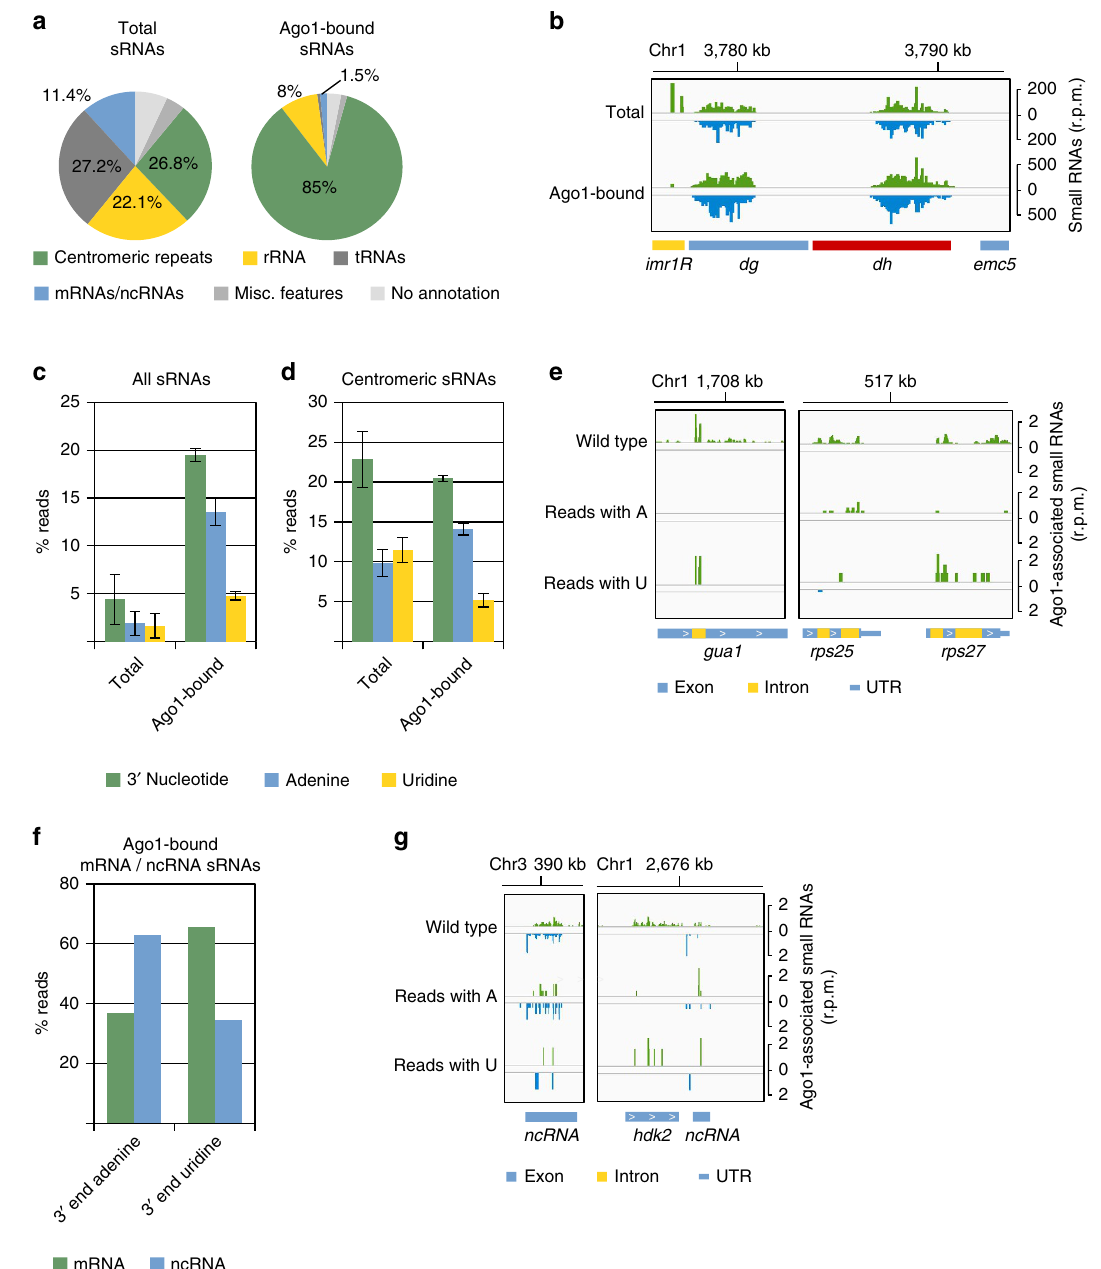
Figure 1 | Argonaute-bound sRNAs have non-templated nucleotides at the 3 0 end. ( a ) Argonaute-bound and total sRNAs were analysed by high- throughput sequencing from wild-type cells and classified as indicated below the pie charts. Pie charts illustrate percentages for the individual sRNA classes relative to the total number of reads for each strain. ( b ) Argonaute-bound and total sRNA reads from wild-type cells were plotted over centromeric region. The location of genes is indicated below the sRNA peaks. Reads from þ and (cid:2) strands are depicted in green and blue, respectively. Scale bars on the right denote sRNA read numbers normalized per one million reads. ( c ) Quantification of sRNAs that have non-templated nucleotides at the 3 0 end in Argonaute-bound and total sRNA sample. Error bars indicate s.e.m. of two independent sRNA-sequencing experiments. ( d ) Quantification of centromeric sRNAs that have non-templated nucleotides at the 3 0 end in Argonaute-bound and total sRNA sample. Error bars indicate s.e.m. of two independent sRNA-sequencing experiments. ( e ) Argonaute-bound sRNA reads from wild-type cells were plotted over euchromatic region. Reads having non-templated adenine(s) or uridine(s) at the 3 0 end are shown in separated tracks. The location of genes is indicated below the sRNA peaks. Reads from þ and (cid:2) strands are depicted in green and blue, respectively. Scale bars on the right denote sRNA reads numbers normalized per one million reads. ( f ) Quantification of Argonaute-bound sRNAs that have non-templated adenine(s) or uridine(s) at the 3 0 end. Non-templated adenine is enriched at sRNAs that originate from non-coding and antisense transcripts. Non-templated uridine is enriched at sRNAs that originate from mRNAs. ( g ) Argonaute-bound sRNA reads from wild-type cells were plotted over euchromatic genes. Reads having non-templated adenine(s) or uridines(s) at the 3 0 end are shown in separated tracks. The location of genes is indicated below the sRNA peaks. Reads from þ and (cid:2) strands are depicted in green and blue, respectively. Scale bars on the right denote sRNA reads numbers normalized per one million